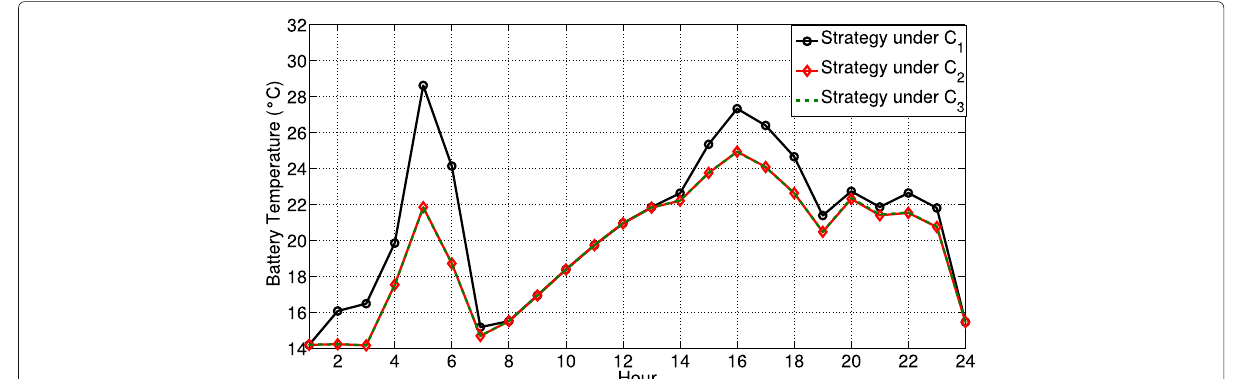
Fig. 11 Average battery temperature of the ideal strategy under the constraint sets C 1 , C 2 , and C